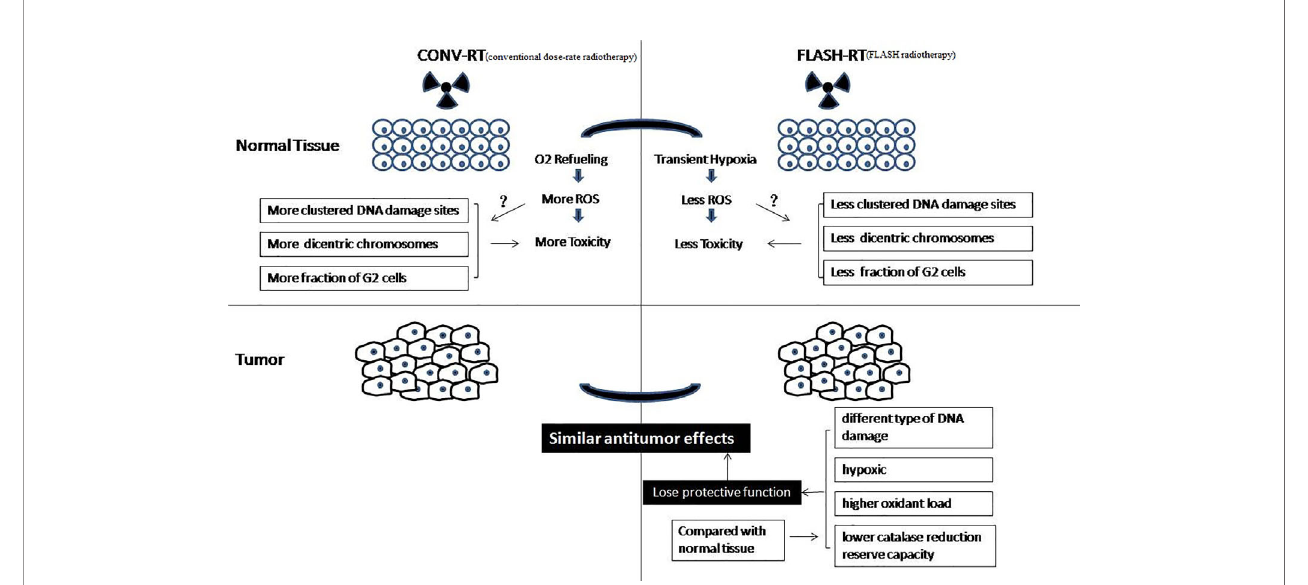
FIGURE 2 | Biological mechanism of